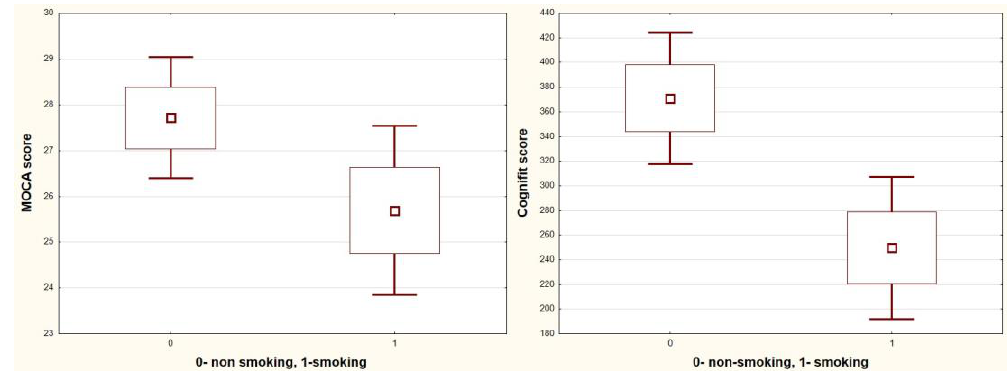
Figure 7. Box-whisker graph of CompBased-CAT (Cognifit score) and MOCA vs. smoking. Multivariate Analysis